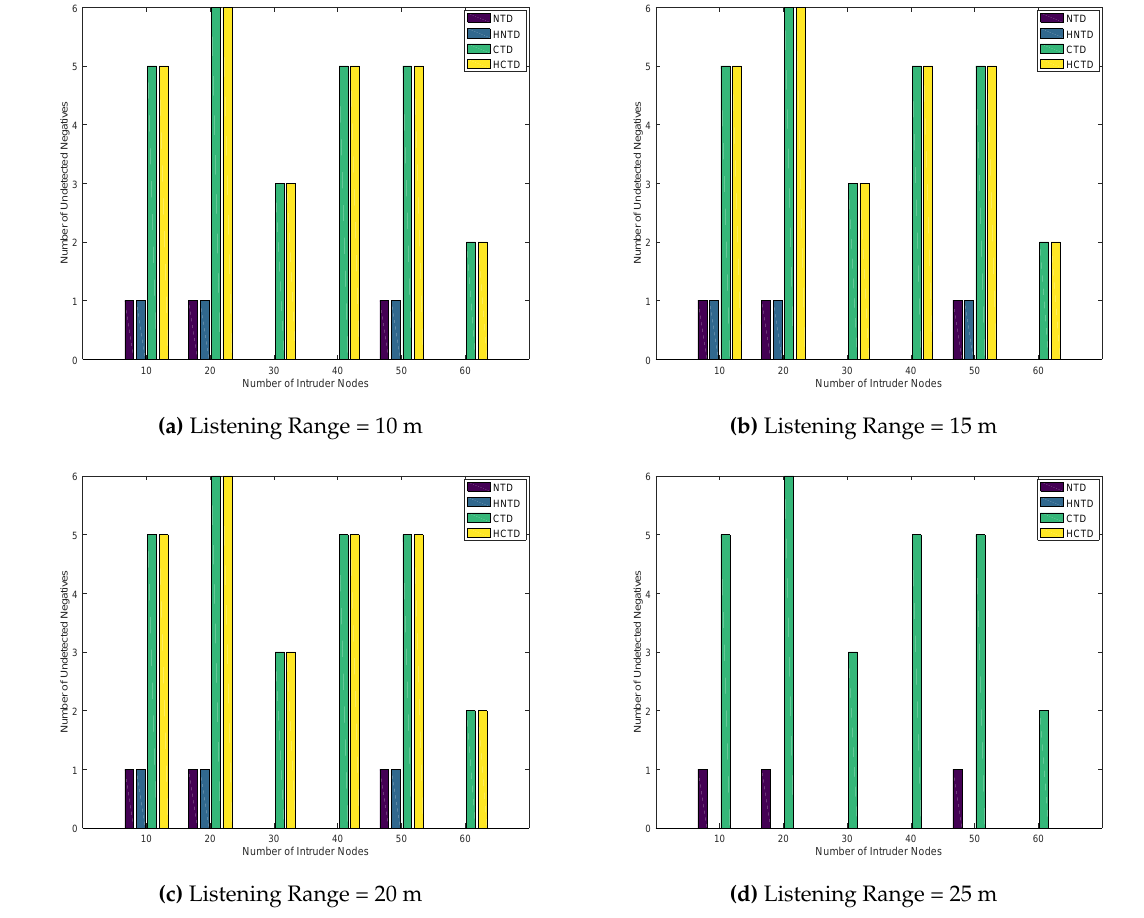
Figure 12. Number of Undetected Negatives for Randomly placed